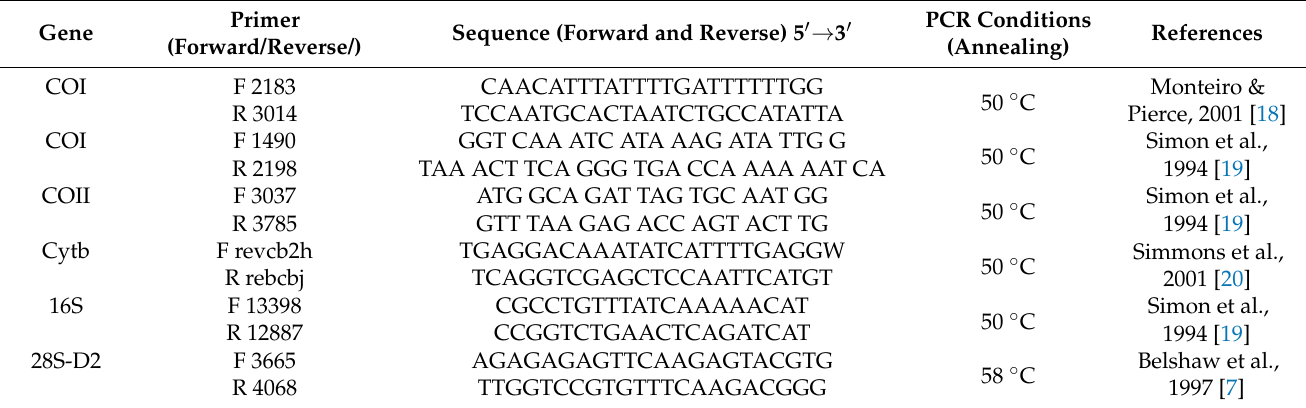
Table 1. Primer sequences for